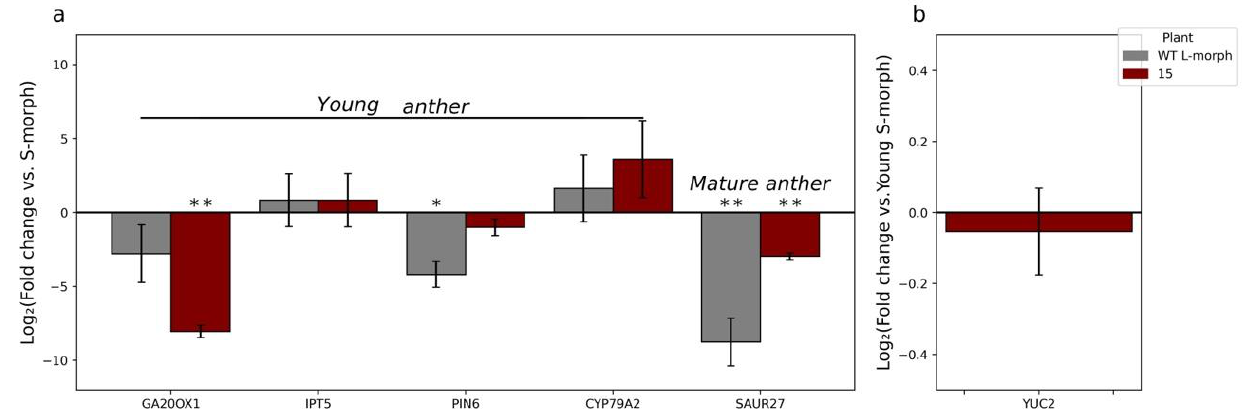
Figure 5. RT-qPCR analysis of previously identified differentially expressed auxin-related genes in T 0 -15. * = p -value < 0.05, and ** = p -value < 0.01. p -values determined by Student’s t -test comparing the ∆ CT of T 0 -15 or WT L-morph anthers, with that determined for WT S-morph anthers, at the stages as labelled. Error bars represent the standard error of the fold change. Values represent the log2(fold change). Note, ( b )’s scale is extremely small compared to ( a )’s scale to better represent the miniscule and insignificant difference in expression.